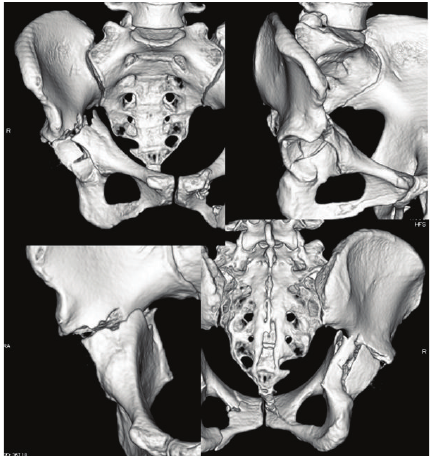
Figure 2: Three-dimensional computed tomography images show- ing a transverse fracture and posterior wall fracture of the right acetabulum.